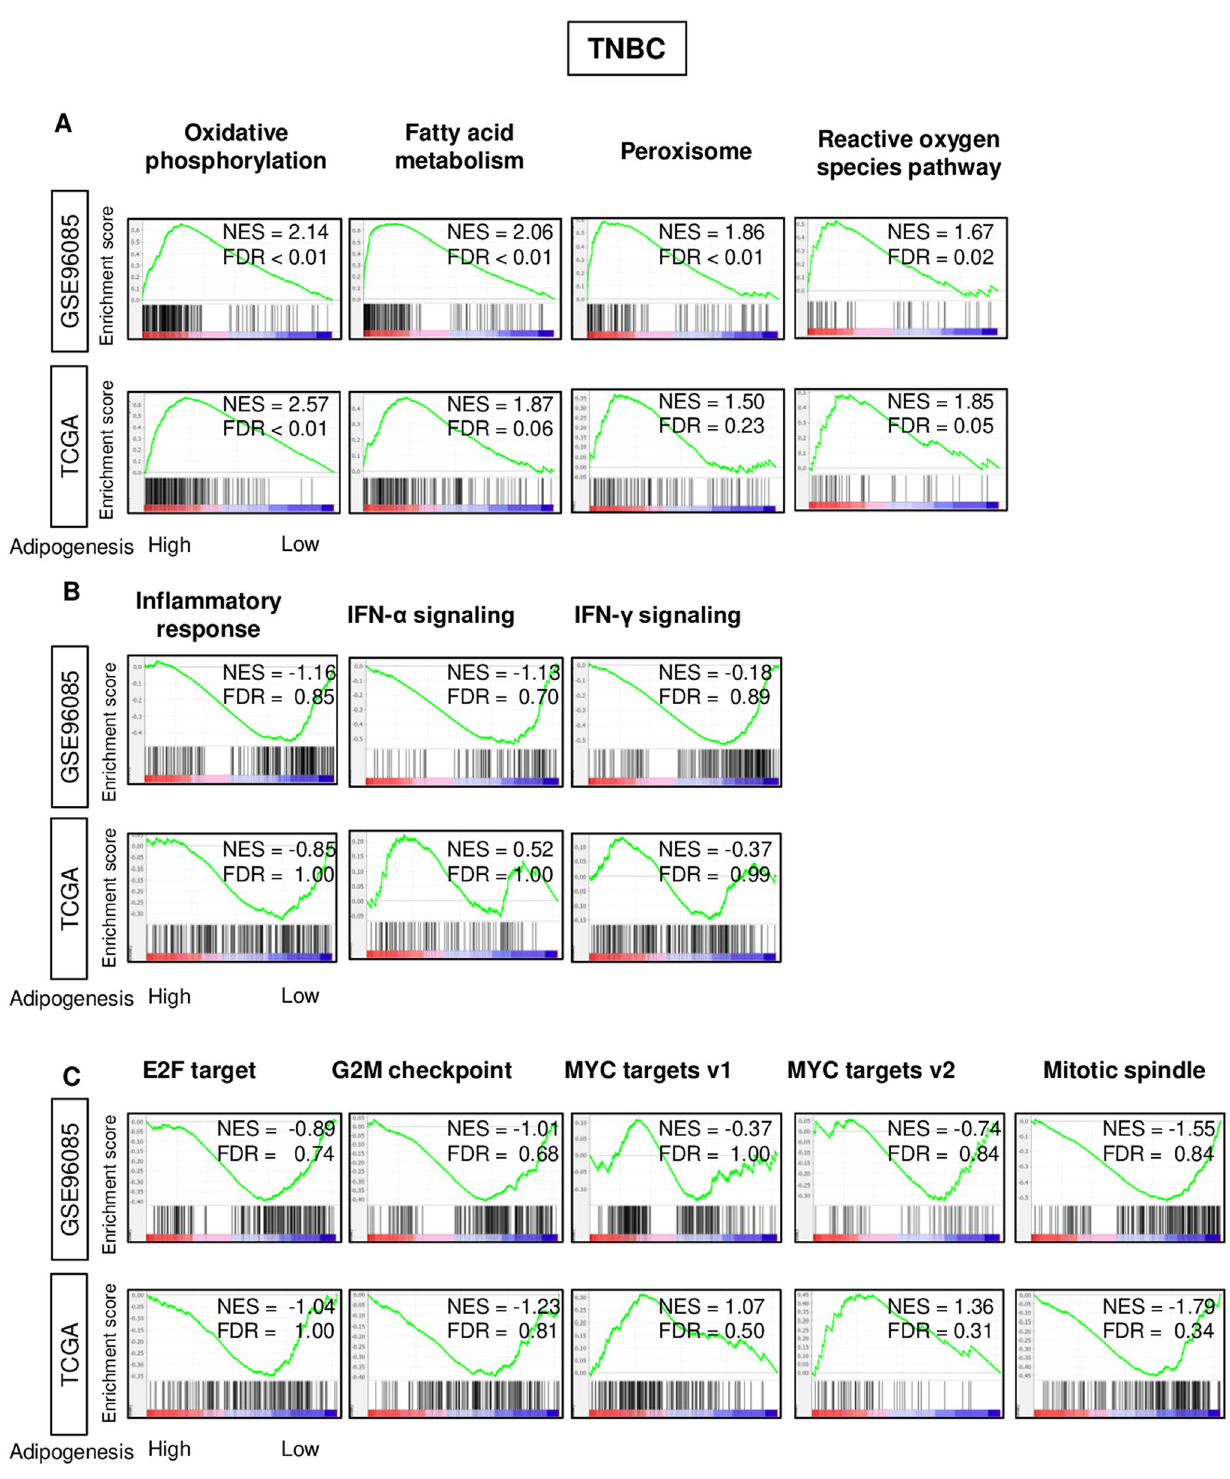
Figure 4. Gene Set Enrichment Assay (GSEA) on adipogenesis score in TNBC of both GSE96058 and TCGA cohorts. Gene set enrichment plots of (A) Hallmark metabolism-related gene sets (oxidative phosphorylation, fatty acid metabolism, peroxisome, reactive oxygen species pathway) (B) inflammation-related gene sets (inflammatory response, interferon (IFN)-α response and IFN-γ response) and ( C ) cell proliferation-related gene sets (E2F target, G2M checkpoint, mitotic spindle, and MYC target v1 and v2) in both cohorts with normalized enrichment score ( NES ) and false discovery rate ( FDR